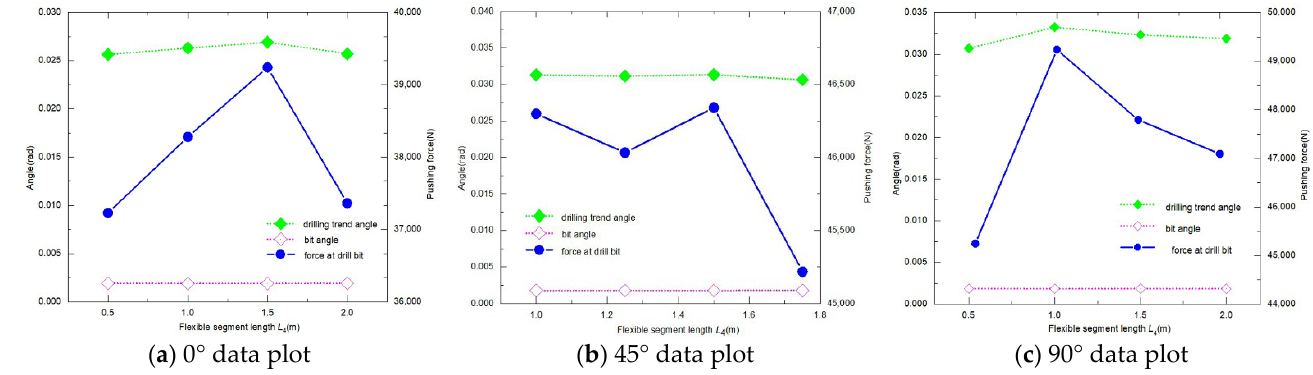
Figure 6. Influence of the flexible segment length (L4) on trajectory control capacity of the tool.